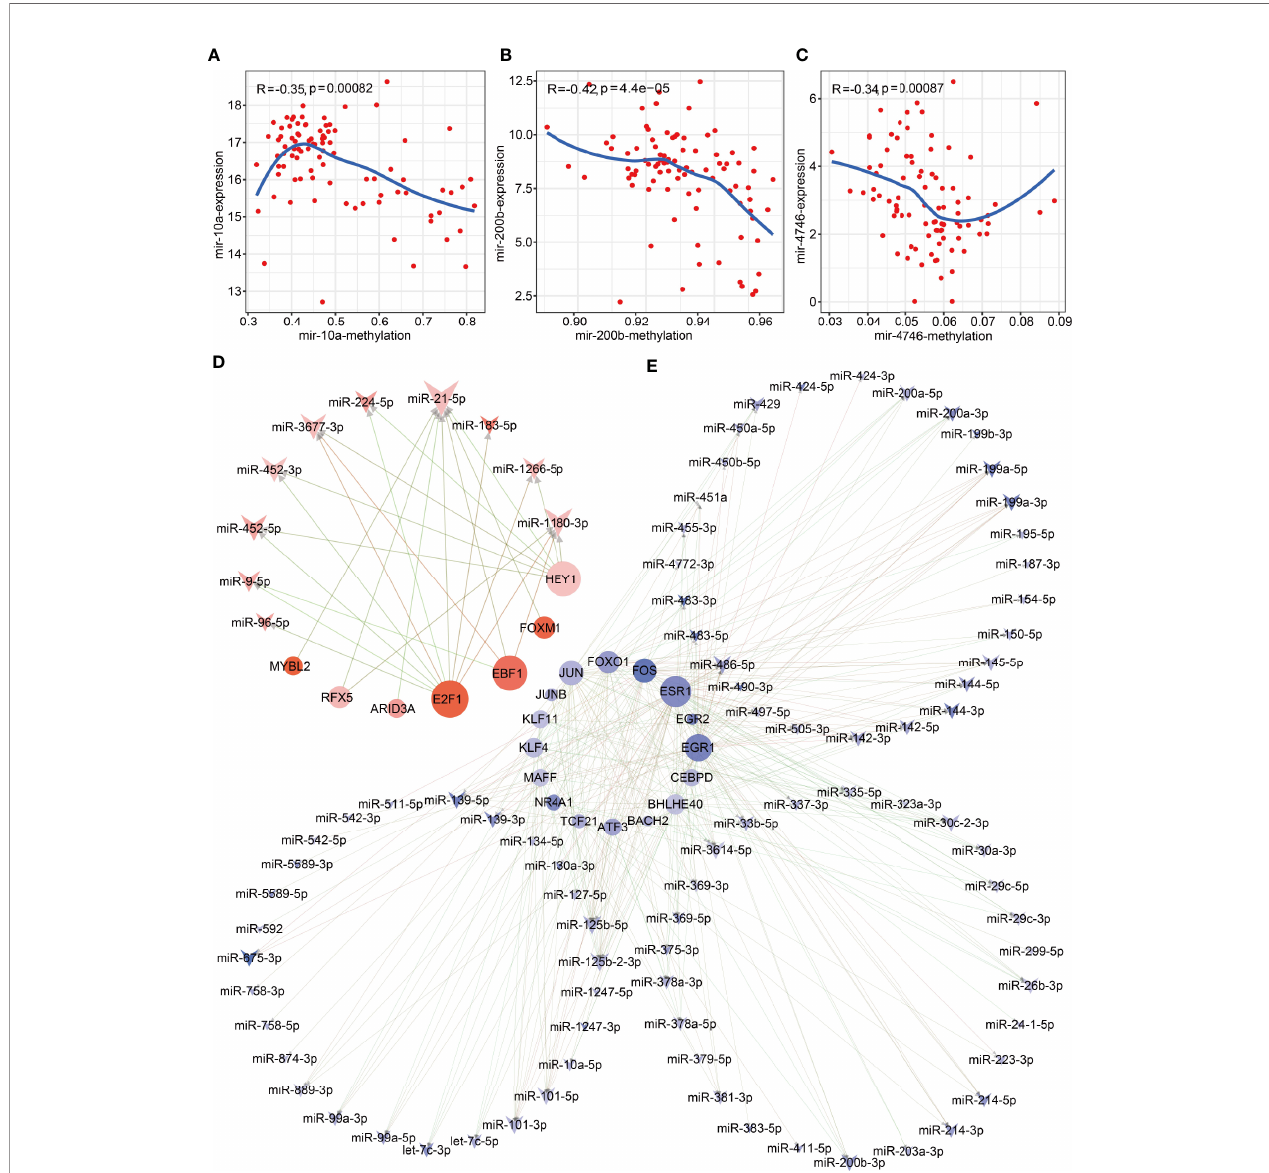
FIGURE 1 | Methylation drivers and transcription factor imbalances cause dysregulated miRNA expression. Correlation between expression and promoter region methylation of pre-miRNAs. (A) Spearman correlation diagram of mir-10; (B) Spearman correlation diagram of mir-200b; (C) Spearman correlation diagram of mir- 4746. Network diagram of transcription factors regulating miRNAs. (D) Up-regulated transcription factors regulate up-regulated miRNAs; (E) Down-regulated transcription factors regulate down-regulated